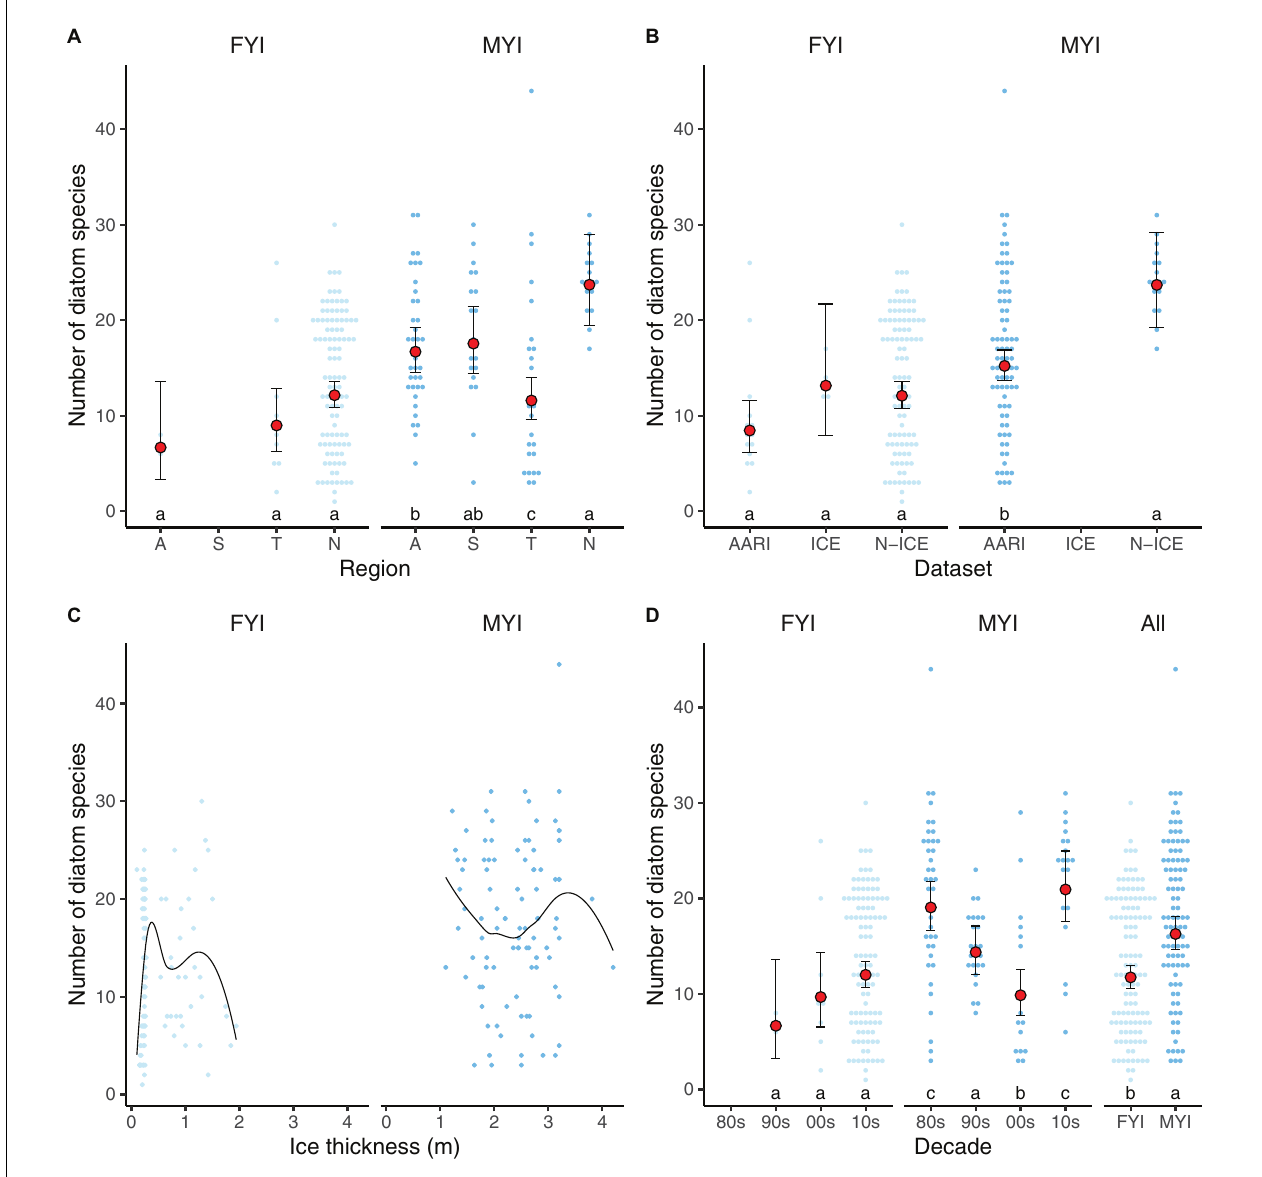
FIGURE 3 | Diatom species richness over the regions (A) in the Amerasian Basin [A], Siberian Shelf-Slope [S], Transpolar Drift [T], and North of Svalbard [N], through datasets (B) , ice thickness and type, with lines as LOESS fit (C) , and through the four decades (D) included in the meta-analysis (“All” implies decades combined for first-year ice and multiyear ice). Light and dark blue dots indicate diatom diversity in first-year ice (FYI) and multiyear ice (MYI), respectively. Red dots indicate GLMM model estimates, with their 95% confidence intervals. Letters on top of x-axis represent multiple Tukey comparisons using the GLMMs, Holm correction and p -value limit of ≤